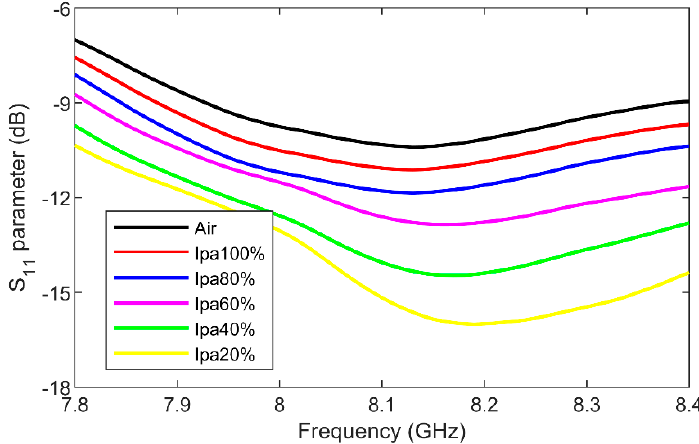
Figure 13. The S 11 parameter of the combined custom-made PCB with loaded microwave-microfluidic chip filled with different concentrations of the water-isopropanol mixture.